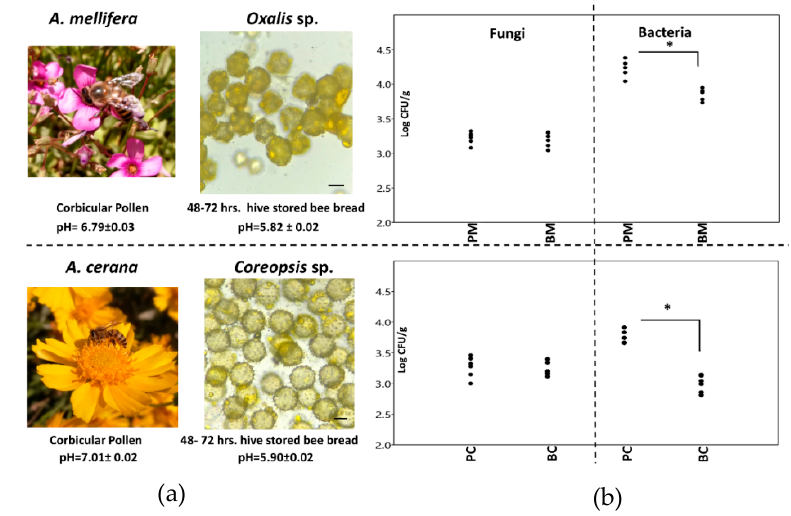
Figure 1. ( a ) The major pollen sources found in the corbicular pollen and hive-stored bee bread of two honey bee species. ( b ) The CFU/g of fungi and bacteria number in corbicular pollen and hive-stored honey bee species. ( b ) The CFU / g of fungi and bacteria number in corbicular pollen and bee bread with an asterisk, indicating a significant difference between the groups ( p < 0.05). CFU: colony-forming unit.